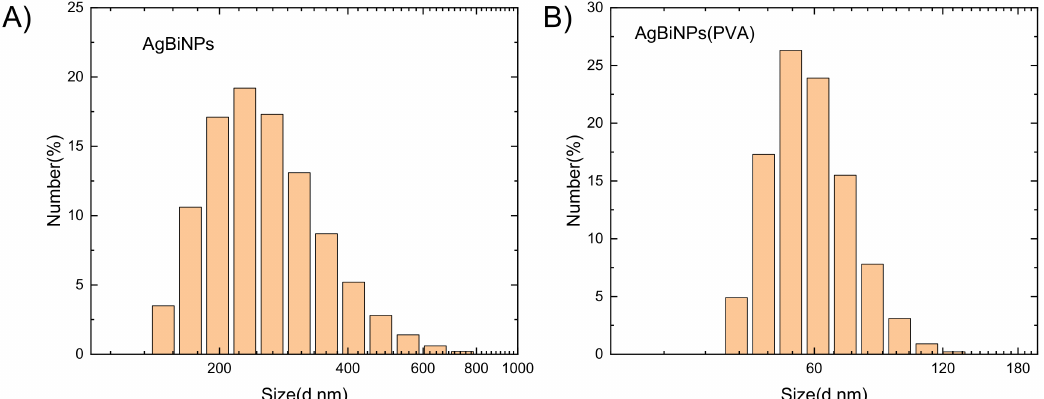
Figure 5. DLS analysis results in the form of particle size histograms according to distribution for ( A ) a solution of silver–bismuth nanoparticles synthesized without a stabilizer (PVA). ( B ) A solution of silver–bismuth nanoparticles synthesized in the presence of a stabilizer. Both silver and bismuth concentrations were 1 × 10 − 4 mol/dm 3 .